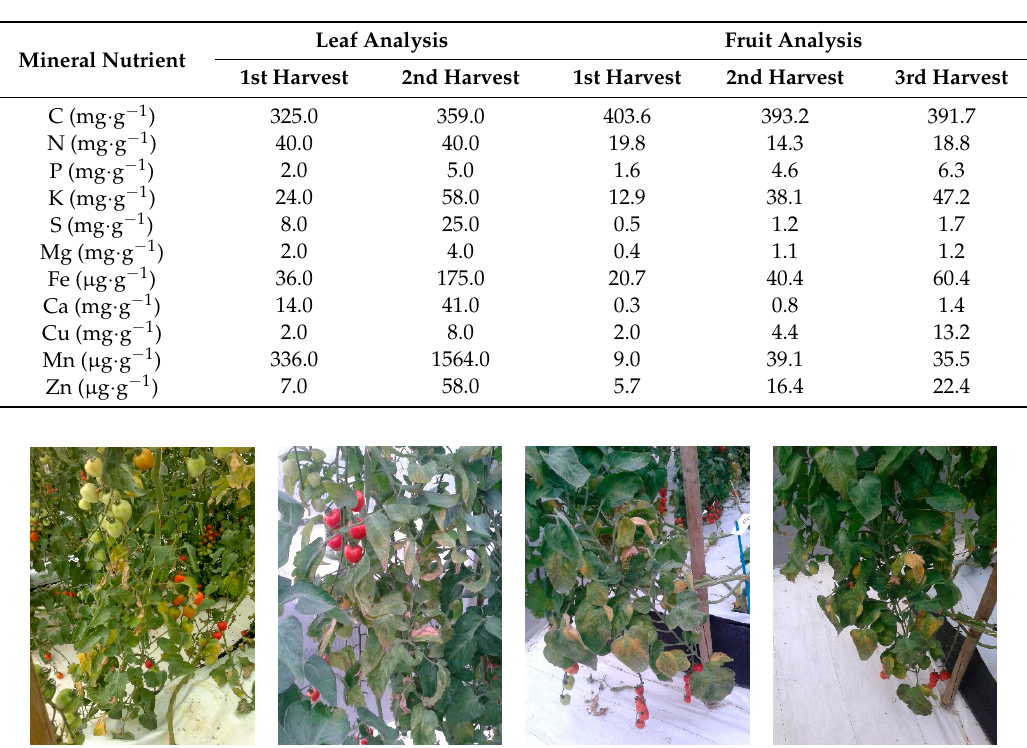
Table A3. Leaf and fruit mineral nutrient concentrations of the commercially produced tomato.